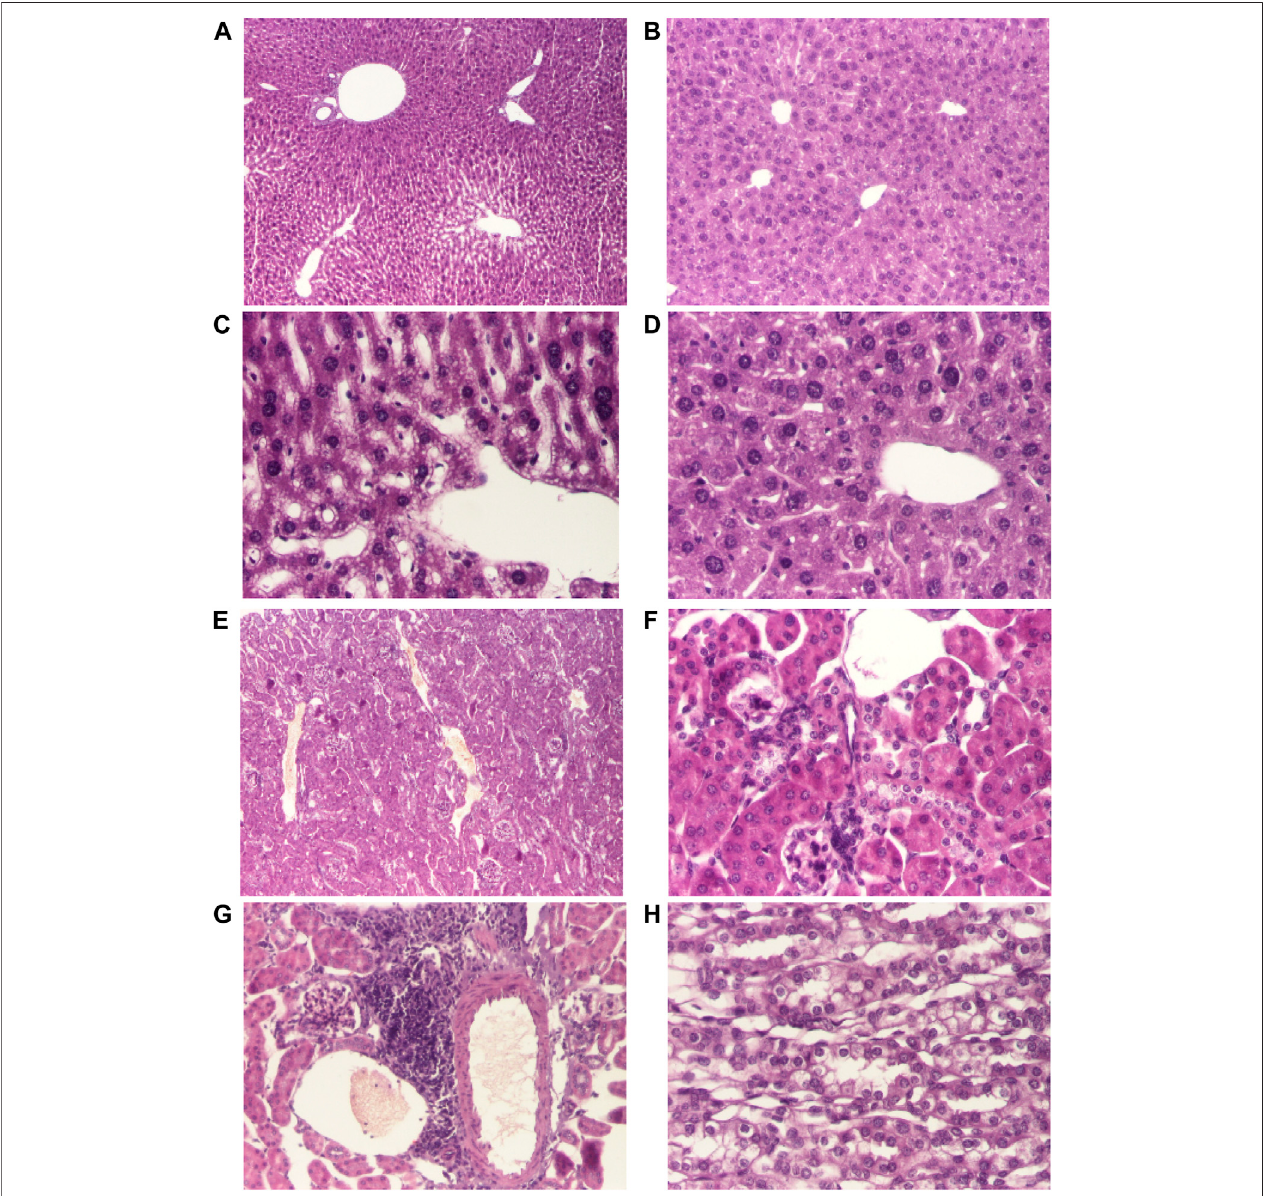
FIGURE 2 | Histological changes of the main organs in the dead mice after doses of 690 mg/kg of AMD/HP- β -CD (A, C, E, G) compared to 440 mg/kg of AMD/ HP- β -CD (B, D, F, H) . Representative pictures from HE staining sections of the liver (hematoxylin-eosin HE stain, × 40) (A, B) , hepatocytes (hematoxylin-eosin HE stain, × 200) (C, D) , renal cortex (hematoxylin-eosin HE stain, × 40) (E) , renal cortex (hematoxylin-eosin HE stain, × 100) (F) , interstitial nephritis (hematoxylin-eosin HE stain, × 100) (G) , renal medulla (hematoxylin-eosin HE stain, × 200) (H) .